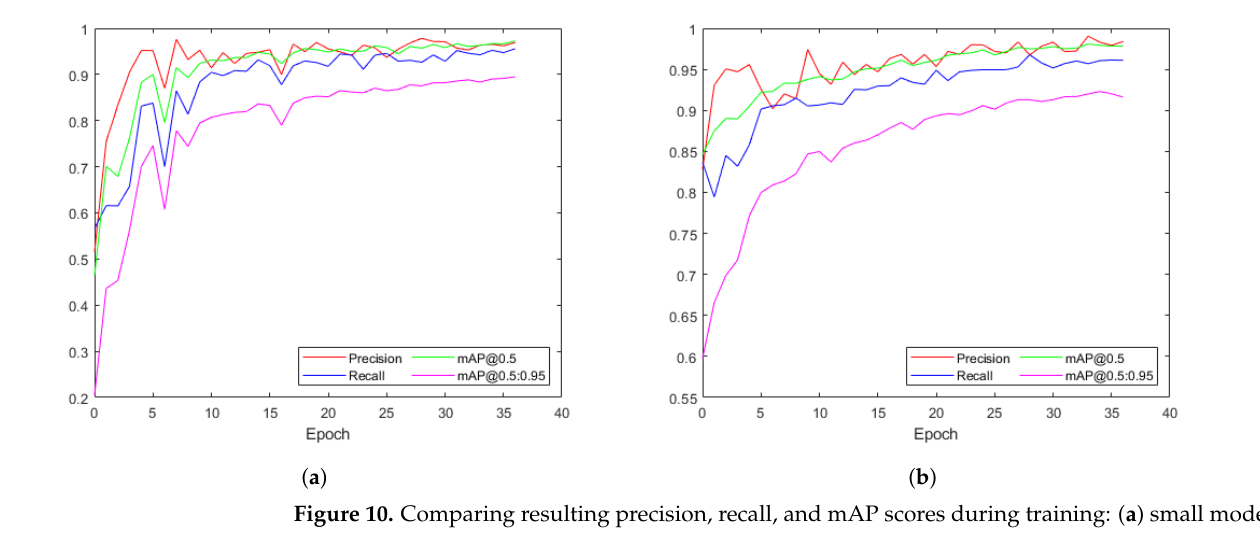
Figure 10. Comparing resulting precision, recall, and mAP scores during training: ( a ) small model; ( b ) xlarge model.